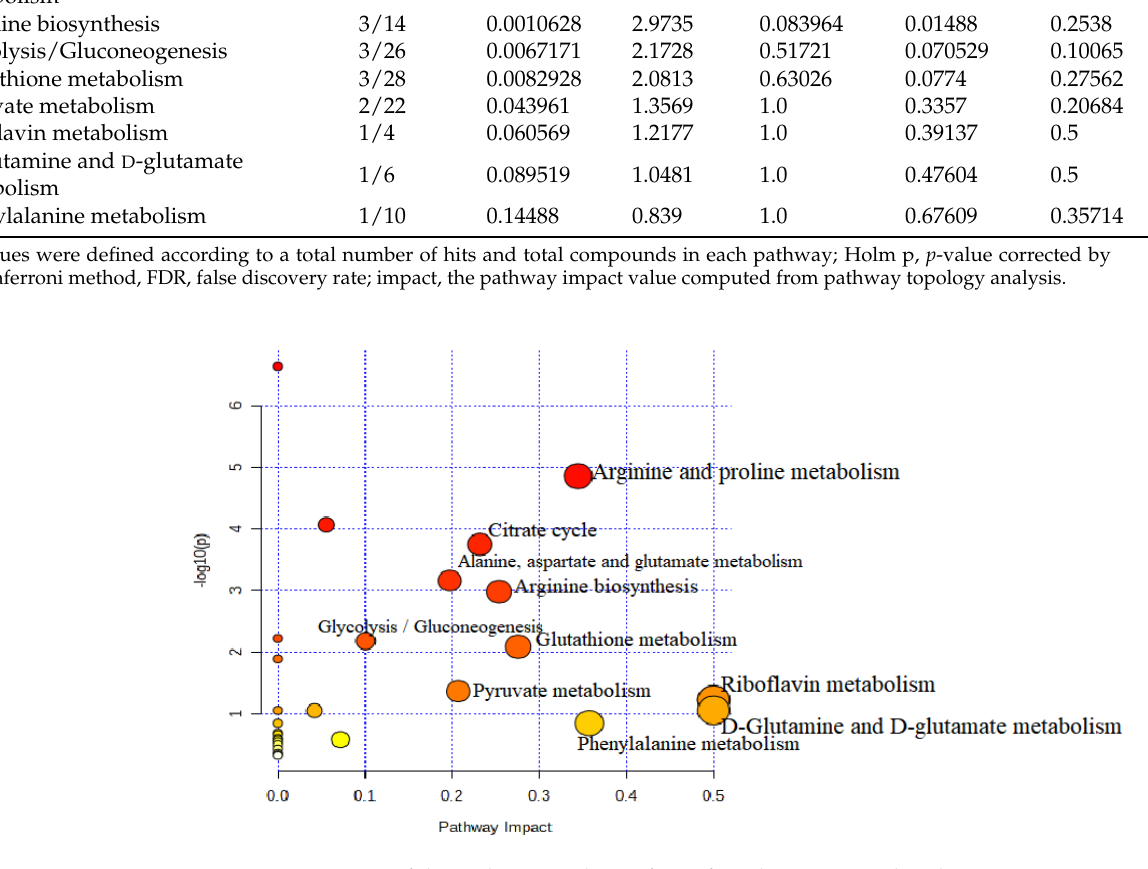
Table 2. Results of the ingenuity pathway analysis of uninfected RBCs treated with AG by using MetaboAnalyst (MetPA) shown the impact values.